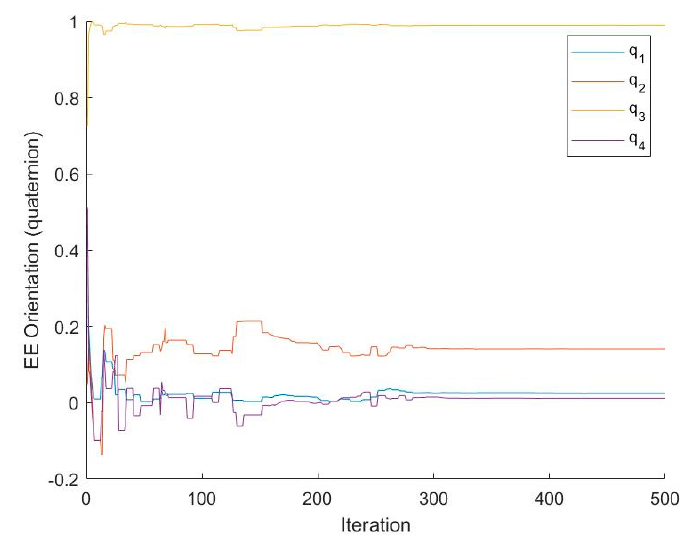
Figure 3. Plot of run 1 EE position.